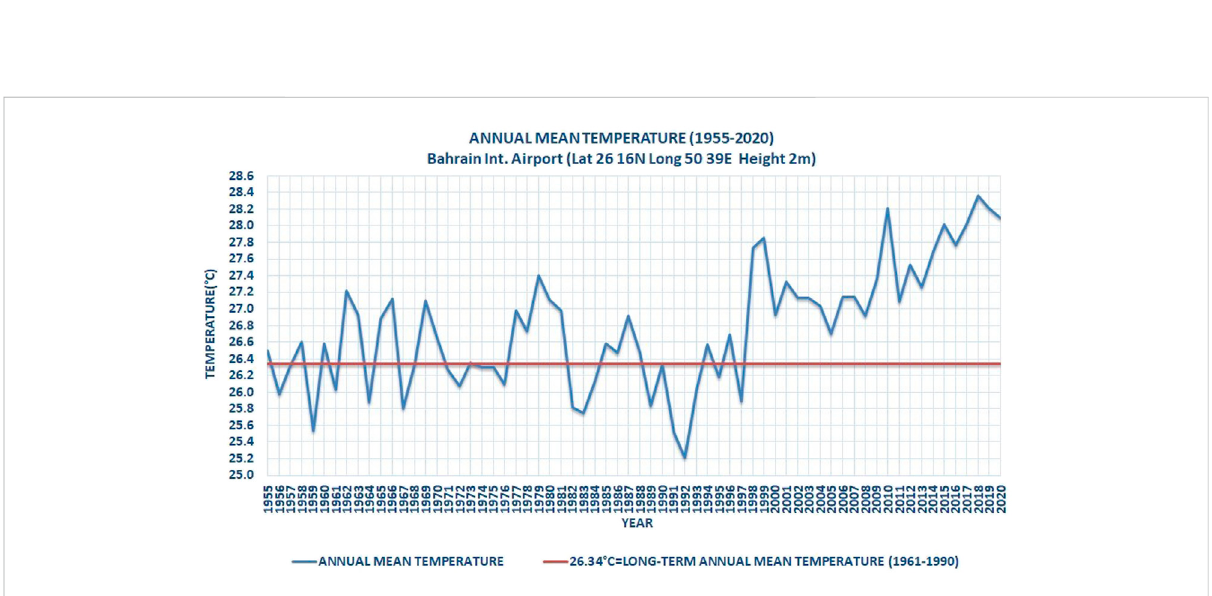
FIGURE 5 Variation of annual mean average temperature in the Kingdom of Bahrain from 1955 to 2020. The long-term annual mean temperature is 26.34 ° C (average of data from 1961 to 1990).